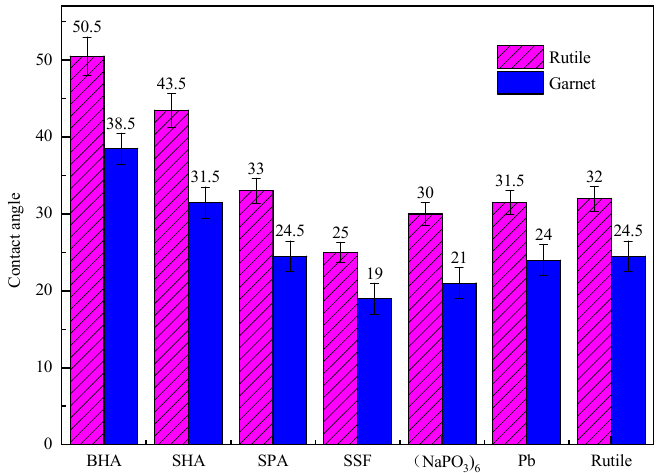
Figure 10. Effects of reagents on the hydrophobicity of rutile and garnet.